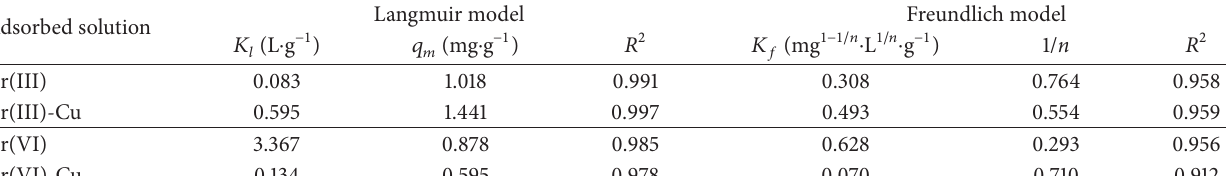
Table 3: Parameters of isotherms for the removal of Cr(III) or Cr(VI) by kaolin in single and binary solutions. Adsorbed solution